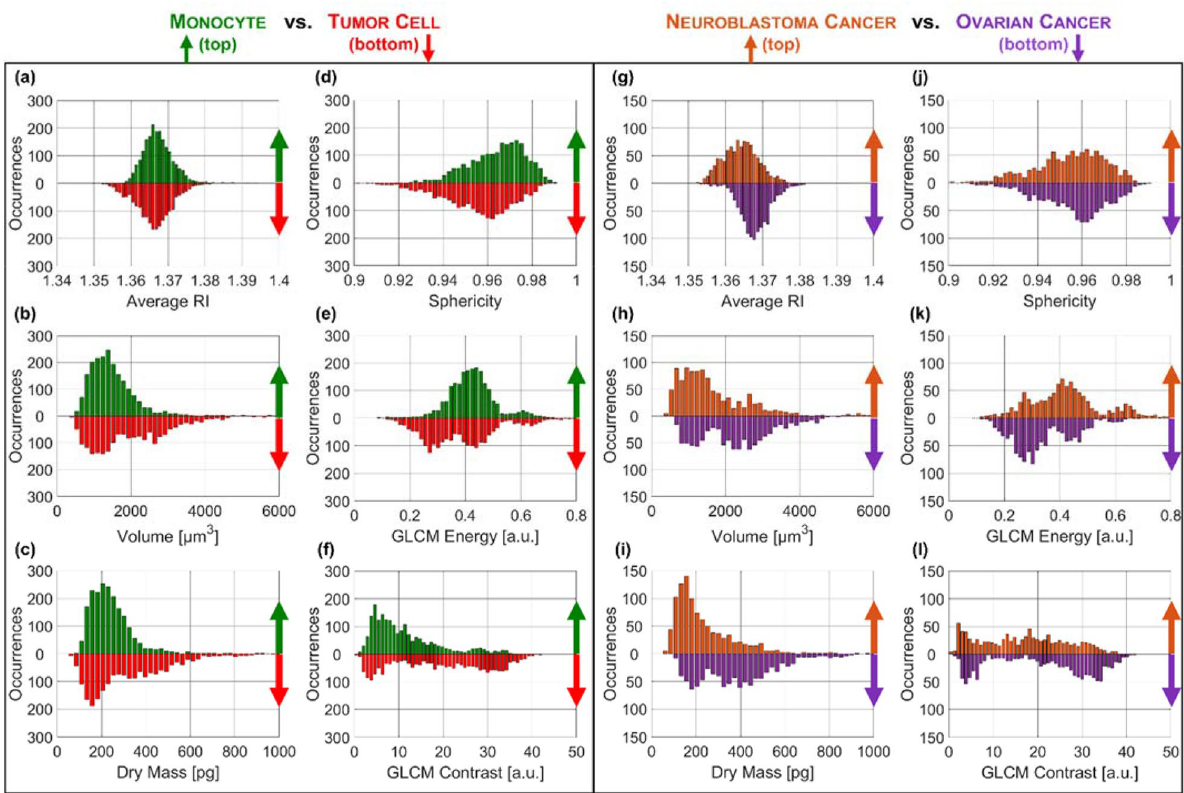
Figure 3. Feature set measured from the augmented training set made of 3D RI tomograms. ( a – f ) Histograms of the average RI, volume, dry mass, sphericity, GLCM energy, and GLCM contrast, respectively, related to the MCs (top) vs. tumor cells (bottom) problem. ( g – l ) Histograms of the average RI, volume, dry mass, sphericity, GLCM energy, and GLCM contrast, respectively, related to the NB (top) versus OC (bottom)